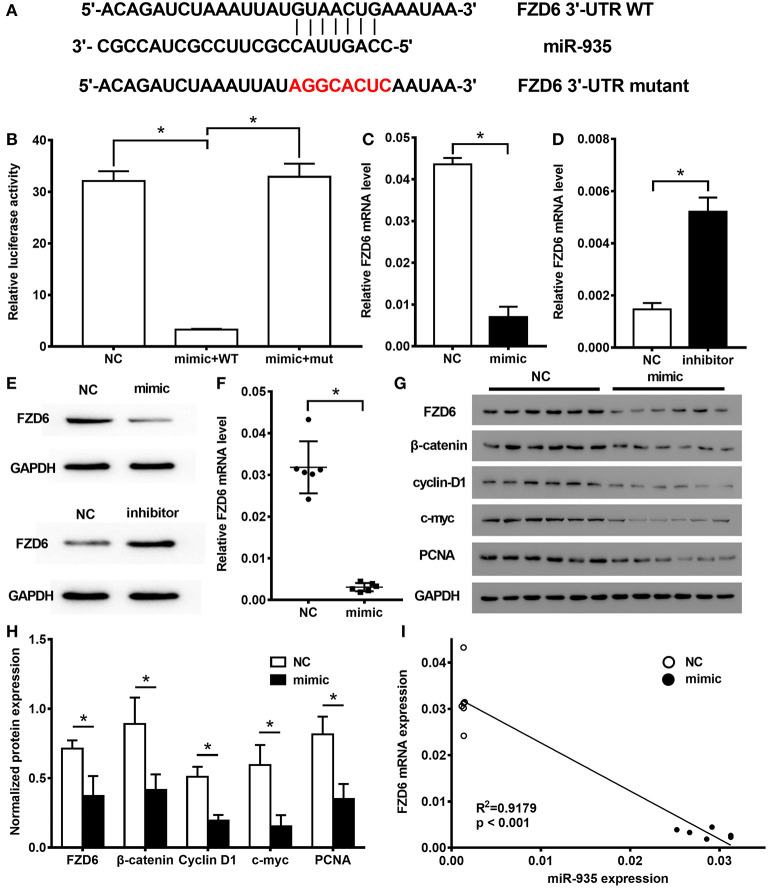
FZD6 is a direct target of miR-935 and it is downregulated in the human glioma cells. (A) The wild-type (WT) or mutant 3′-UTR construct of FZD6 built for the dual-luciferase assay. (B) Luciferase activity of the WT (mimic + WT) or mutant (mimic + mut) 3′-UTR construct of FZD6 in U87 cells after the transfection with miR-935 mimic or the negative control (NC). The quantitative real-time PCR (qRT-PCR) (C,D) and the Western blotting (E) analysis show that mRNA and protein expression of FZD6 were decreased in the miR-935 mimic transfected U87 cells and were promoted in the miR-935 inhibitor-treated SHG44 cells. (F) The qRT-PCR analysis compares the expression of FZD6 between the miR-935 mimic transfected tumors and the control isolated from the xenograft nude mice model. (G,H) The analysis of Western blotting was used to compare the expression of FZD6 and of proliferation-related biomarkers between the miR-935 mimic transfected tumors and the control-treated tumors from the xenograft nude mice model. (I) Negative correlation expression of miR-935 and FZD6 mRNA was generated by the Spearman's rank correlation analysis. *p < 0.05 from the indicated groups in the unpaired Student's t-test was used in the two groups, and a one-way ANOVA, followed by the Bonferroni test, was used to analyze the comparison of multiple groups.